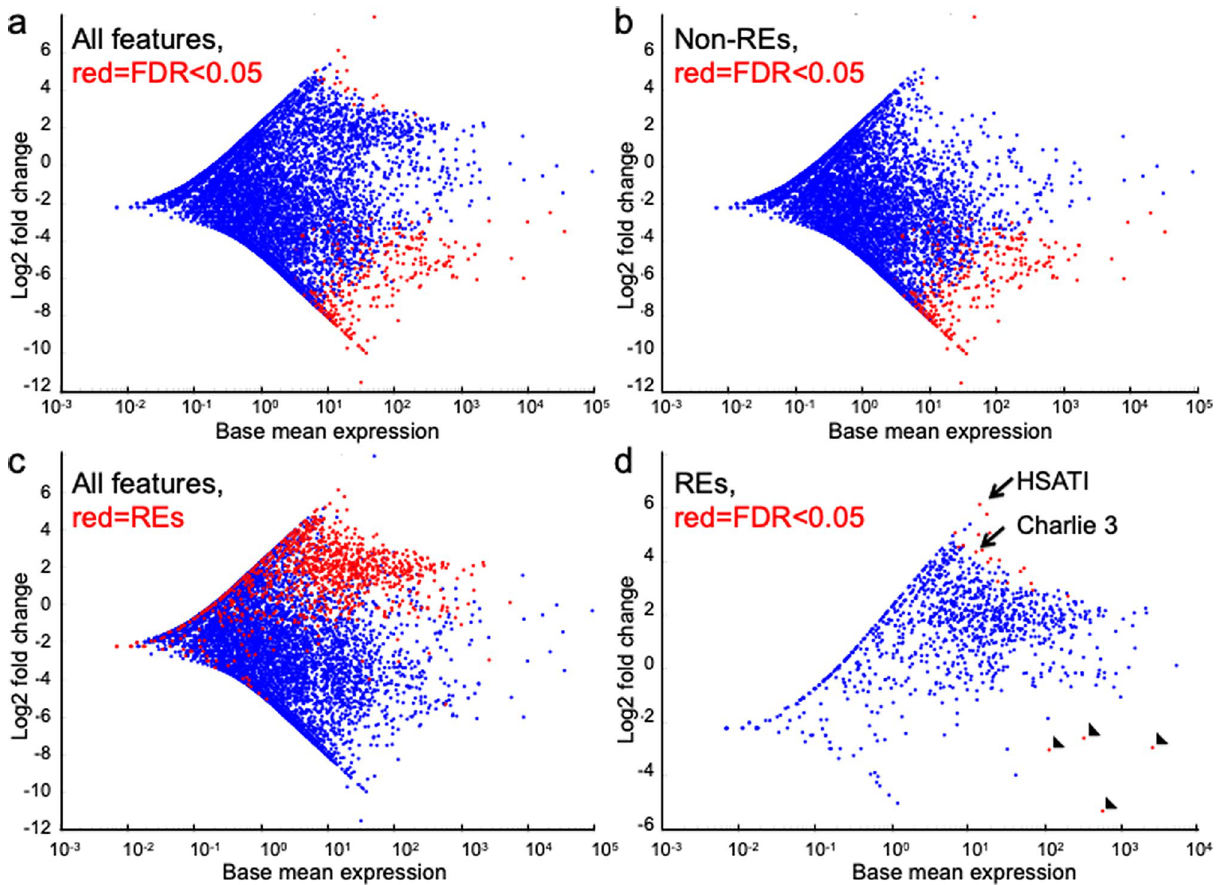
Figure 2. Over-representation of repetitive elements in OS EV–associated sequences. MA plot for sequence features differentially represented in control and OS serum EV preparations as defined by TEtranscripts analysis 1. ( a ) Differentially represented single-copy genes and repetitive elements (REs), significantly differentially represented in red. ( b ) Differentially represented single-copy genes, significantly differentially represented in red. ( c ) Differentially represented single-copy genes in blue and REs in red. ( d ) Differentially represented REs, significantly differentially represented in red. Arrows, the significantly over-represented HSATI and Charlie 3 . Arrowheads, significantly under-represented REs. Significantly differentially represented defined by FDR < 0.05, Wald